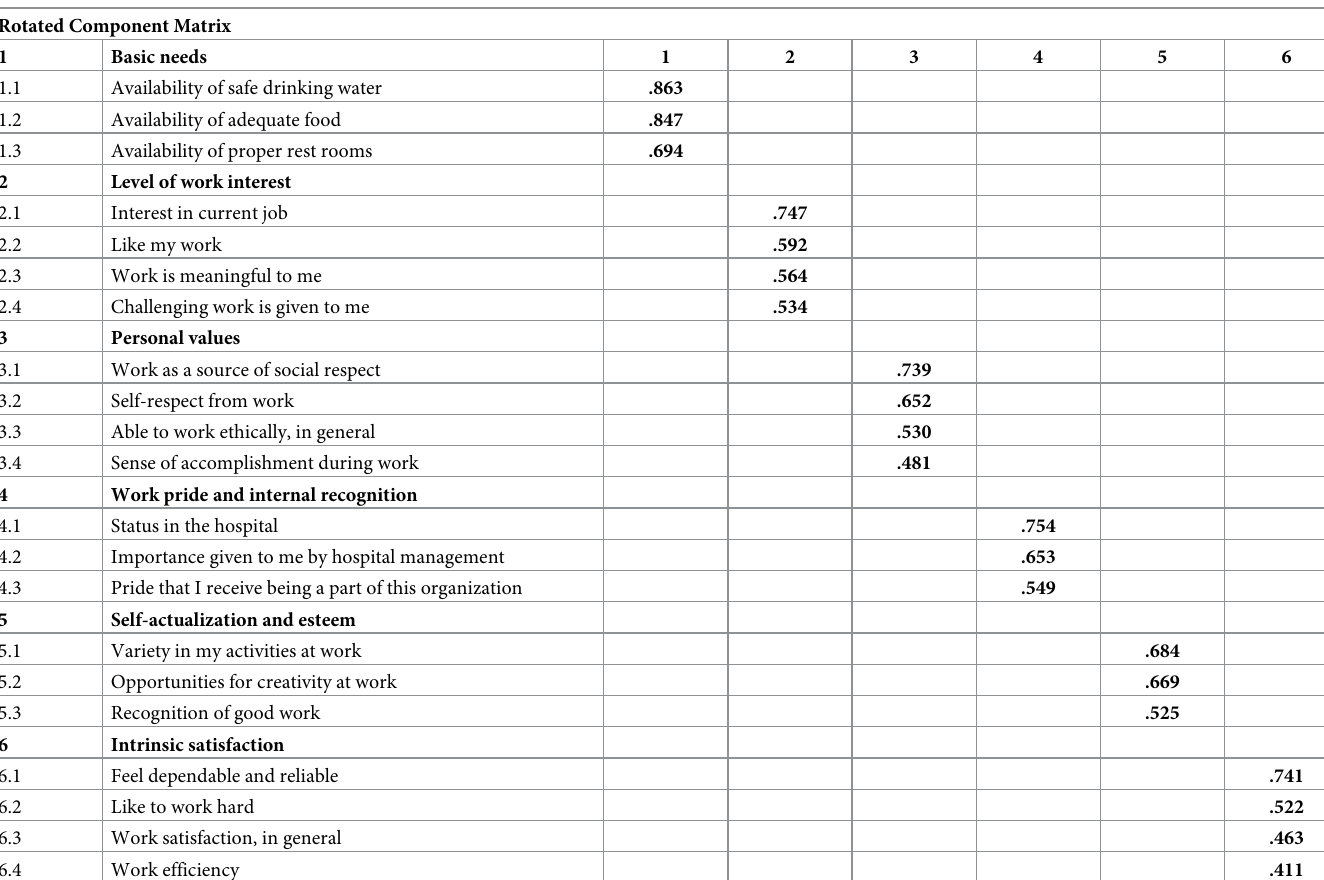
Table 1. Intrinsic